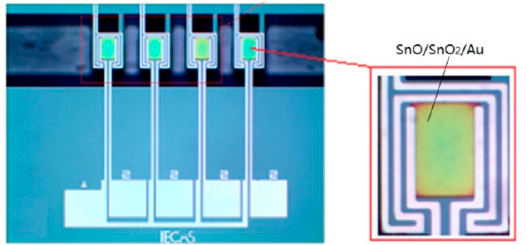
Figure 4. Photo of the MOS array sensor.